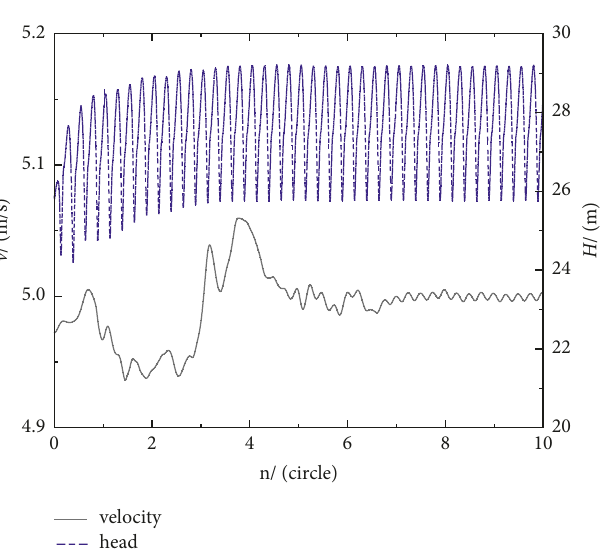
Figure 5: Distribution of head and outlet velocity with respect to impeller